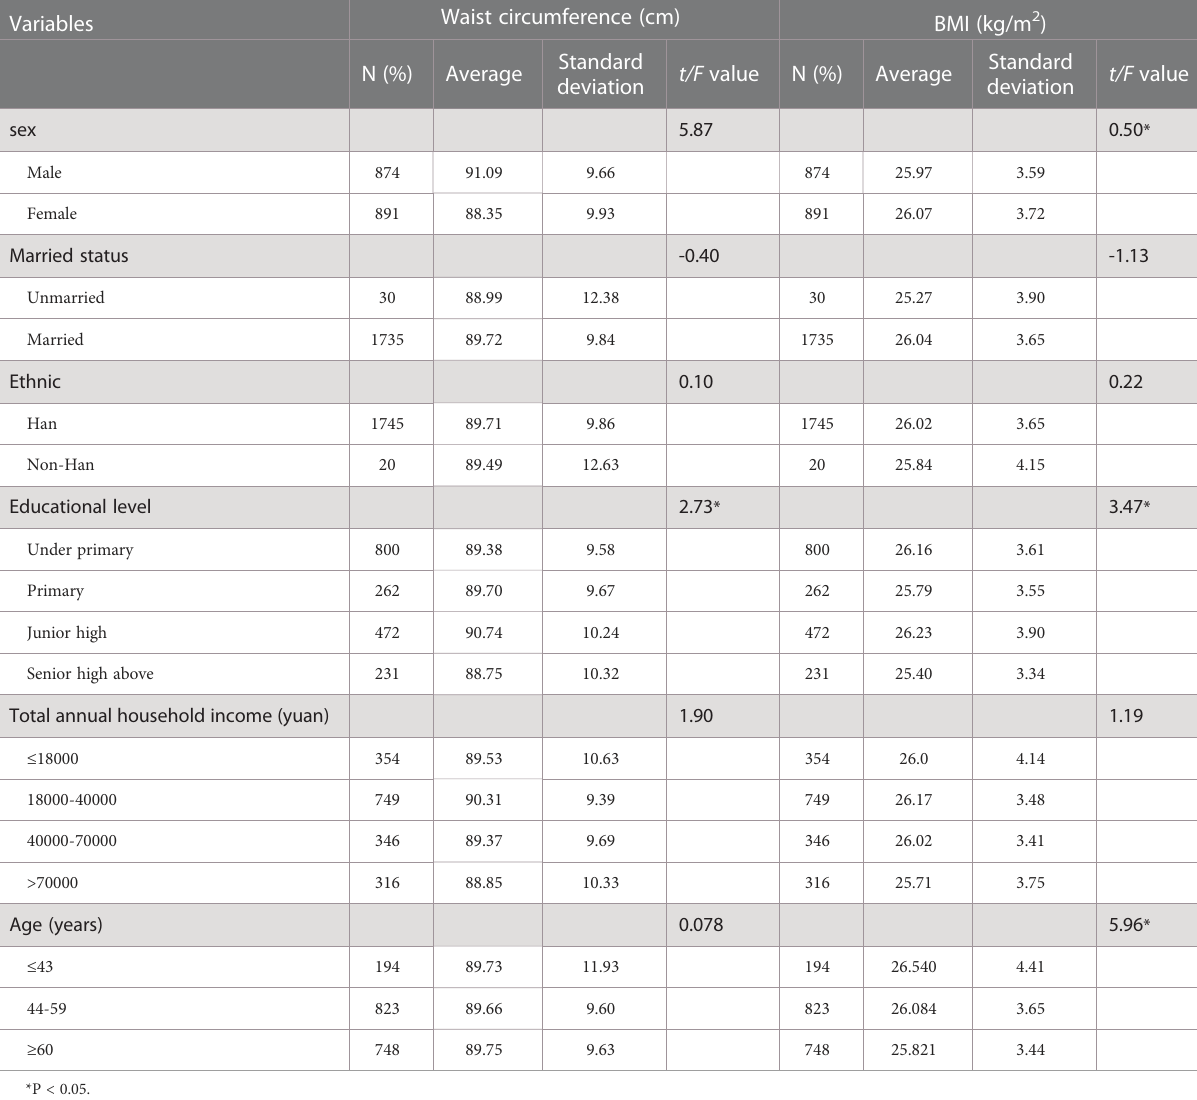
TABLE 1 The prevalence characteristics of waist circumference and BMI.